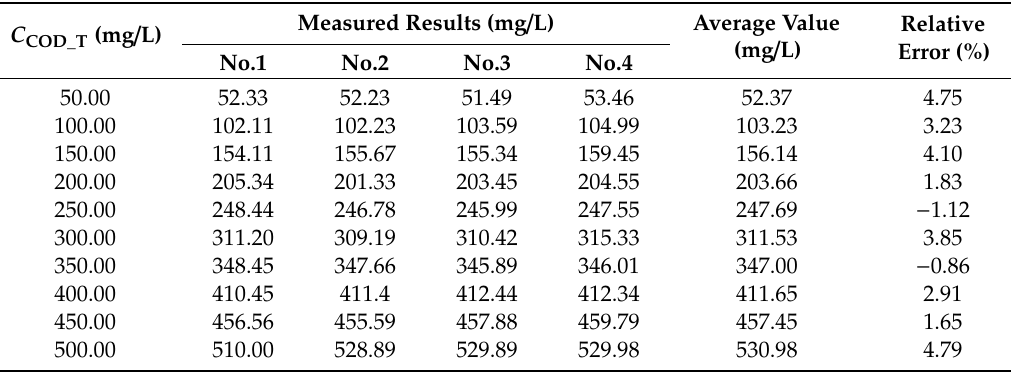
Table 4. Measured results and relative errors for di ff erent concentrations of COD solution. C COD_T (mg / L)